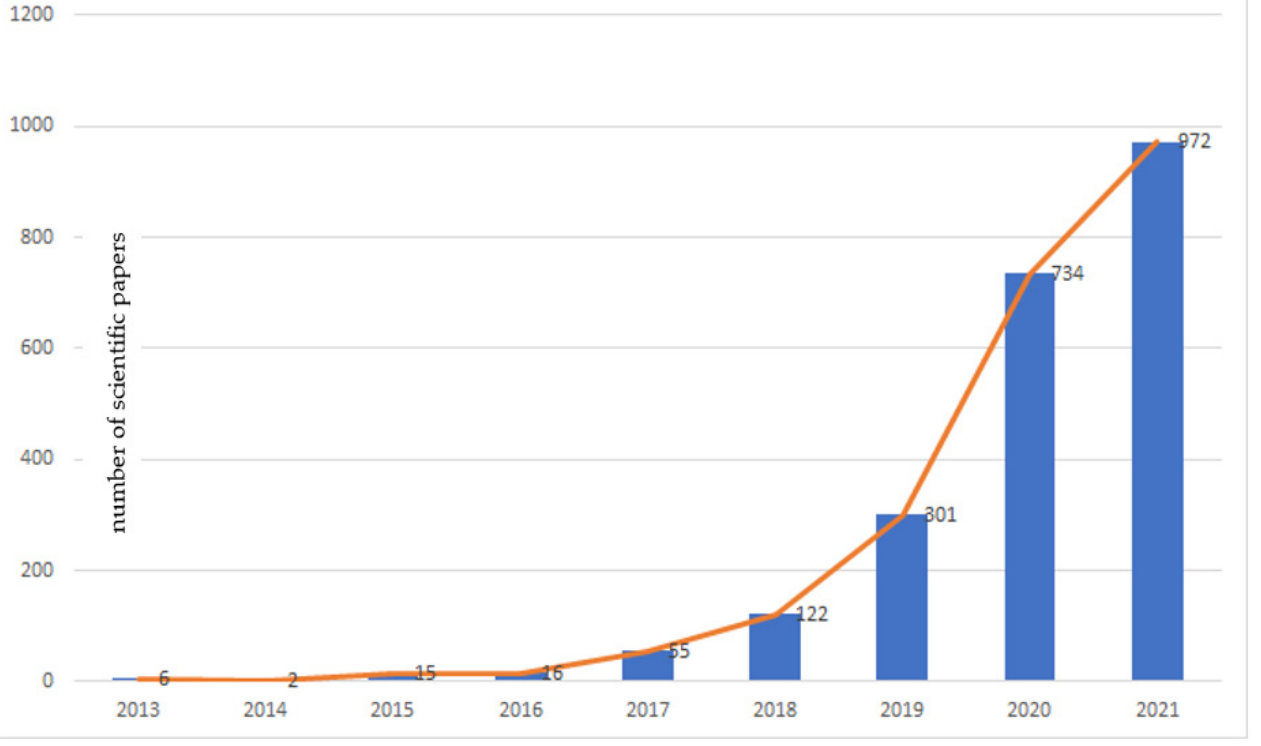
Figure 1. The number of scientific papers and the trend of the scientific interest in the researched topic. Source: processing done by the authors based on the data interrogated in the Scopus database .